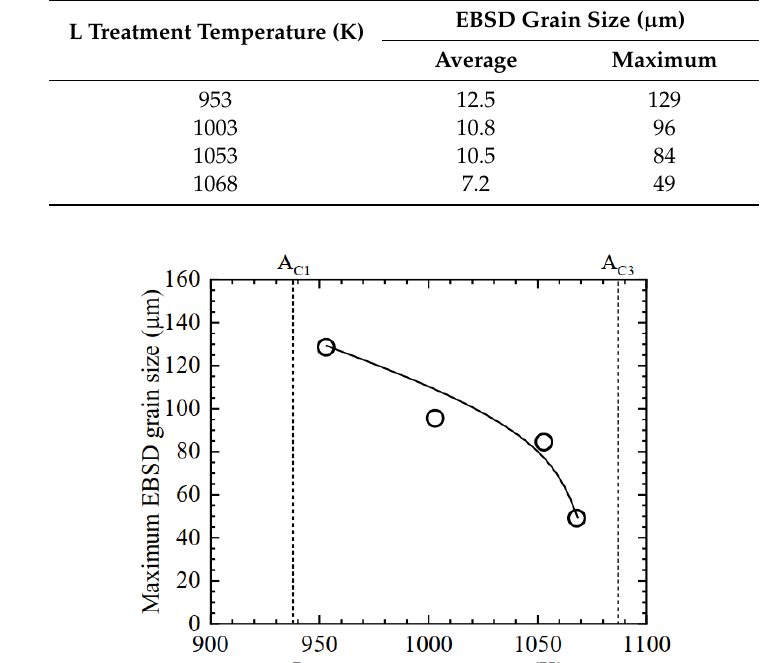
Table 5. The electron back scatter diffraction (EBSD) grain size of Q–L–T samples treated at various temperature. L Treatment Temperature (K)